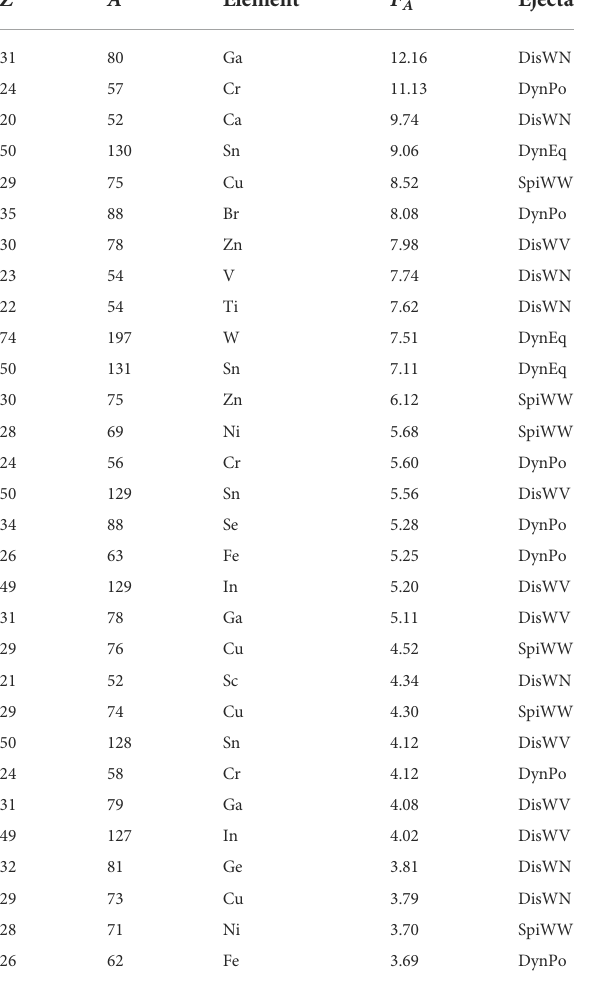
TABLE 2 Top 30 nuclei with maximum nuclear heating rate sensitivity measure D t (see text for details). The maximum value attained at any time t = 0.1, 1, 10, 100 days is set in boldface. For each speci fi c nucleus, the relative D t value is the largest one obtained in the full set of sensitivity studies and refers to the particular type of ejecta